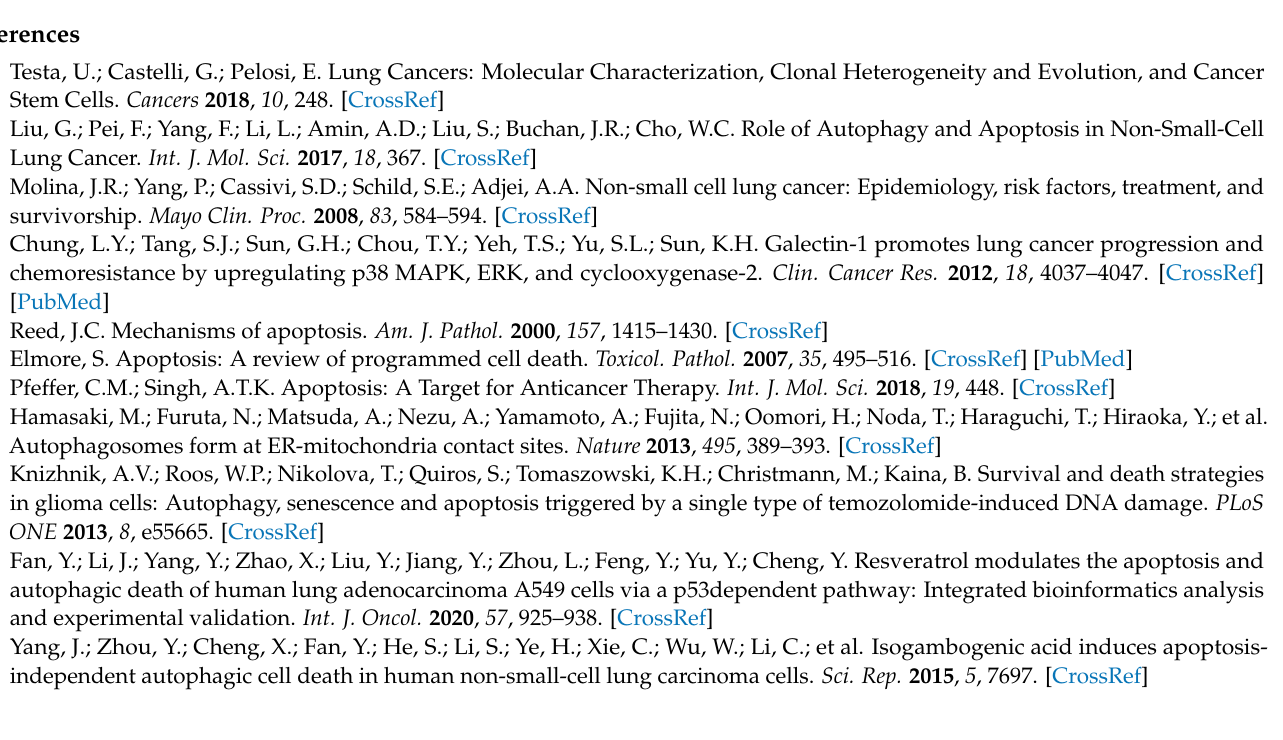
A549 xenograft model, Figure S2: Original images and densitometer analysis of Western blot data in Figure 2A, Figure S3: Original images and densitometer analysis of Western blot data in Figure 2C, Figure S4: Original images and densitometer analysis of Western blot data in Figure 3A, Figure S5: Original images and densitometer analysis of Western blot data in Figure 3C, Figure S6: Original images and densitometer analysis of Western blot data in Figure 4A, Figure S7: Original images and densitometer analysis of Western blot data in Figure 4B, Figure S8: Original images and densitometer analysis of Western blot data in Figure 4C, Figure S9: Original images and densitometer analysis of Western blot data in Figure 5B, Figure S10: Original images and densitometer analysis of Western blot data in Figure 5C, Figure S11: Original images and densitometer analysis of Western blot data in Figure 5E, Figure S12: Original images and densitometer analysis of Western blot data in Figure 6D, Figure S13: Original images and densitometer analysis of Western blot data in Figure 6E, Figure S14: Original images and densitometer analysis of Western blot data in Figure